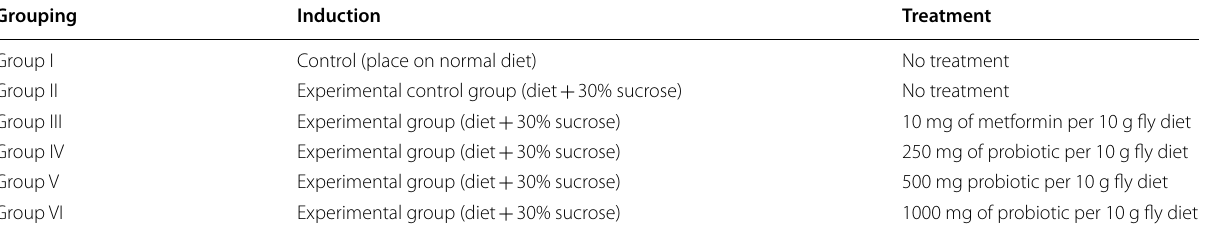
Table 2 Experimental animal grouping of sucrose diet induced Drosophila melanogaster administered with Probiotic (protexin) Grouping